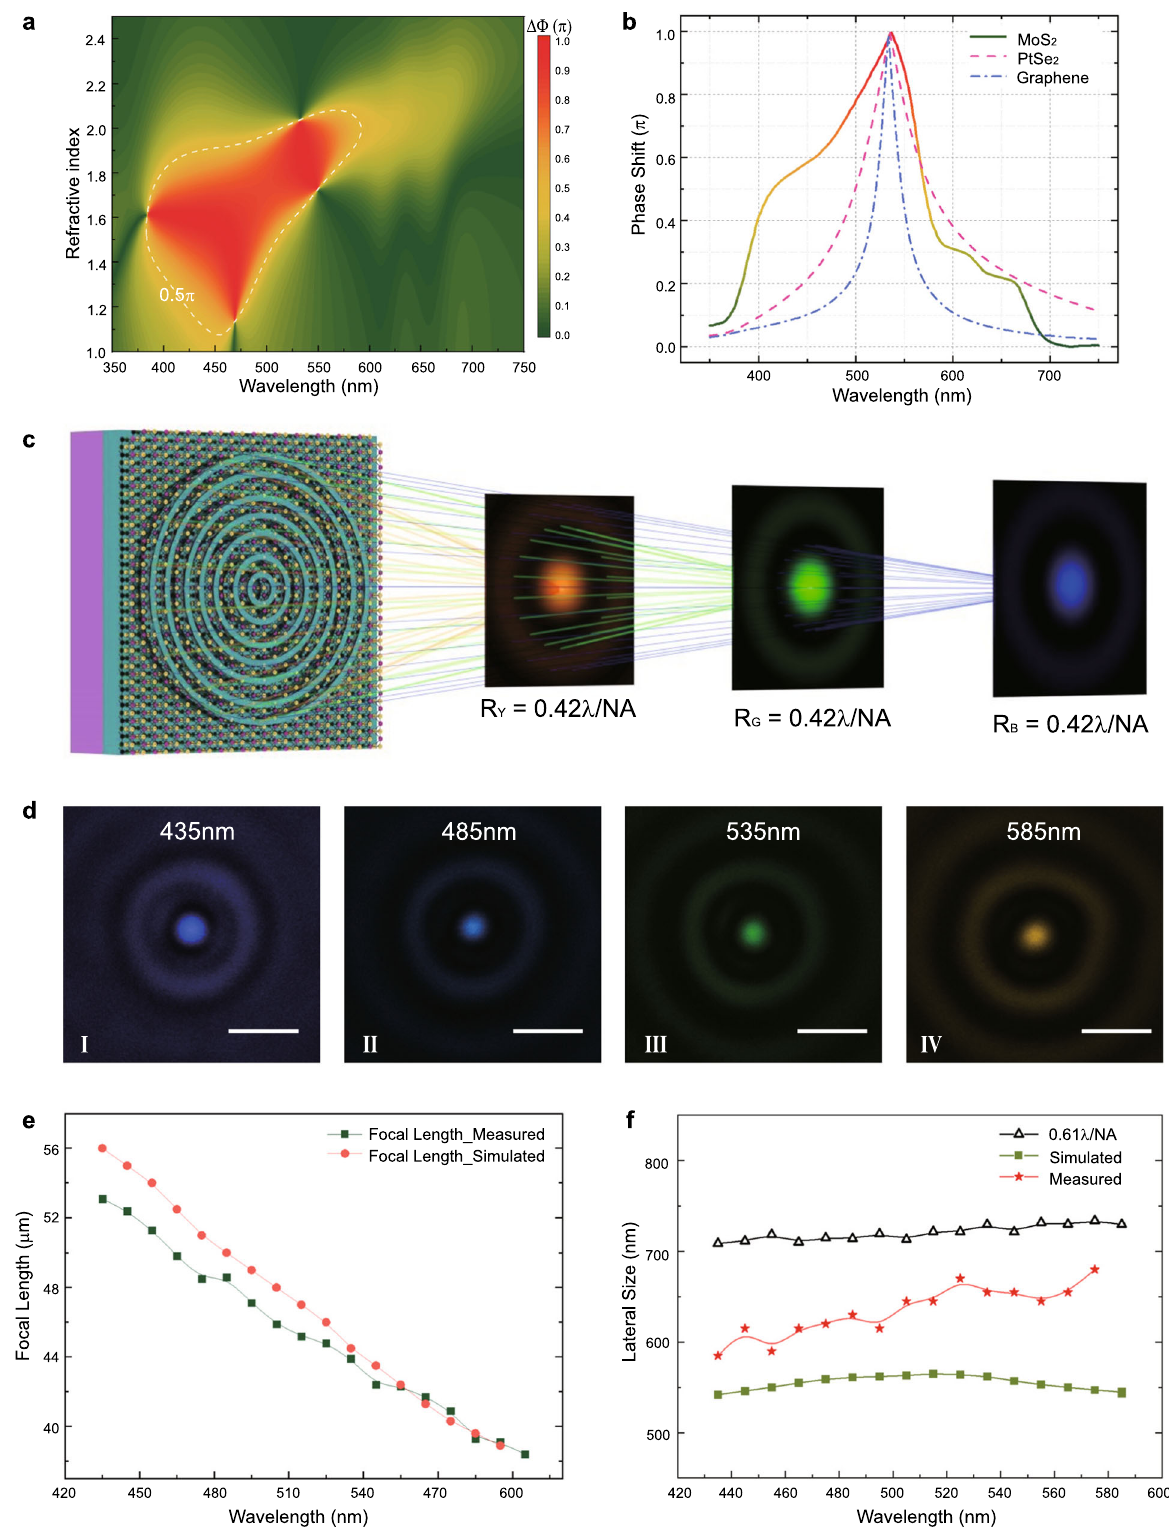
Fig. 4c. By using a bilayer MoS 2 sheet on a ZnO/Si substrate, a broadband SCL with optimal parameters following a multi- channel optimization algorithm was fabricated